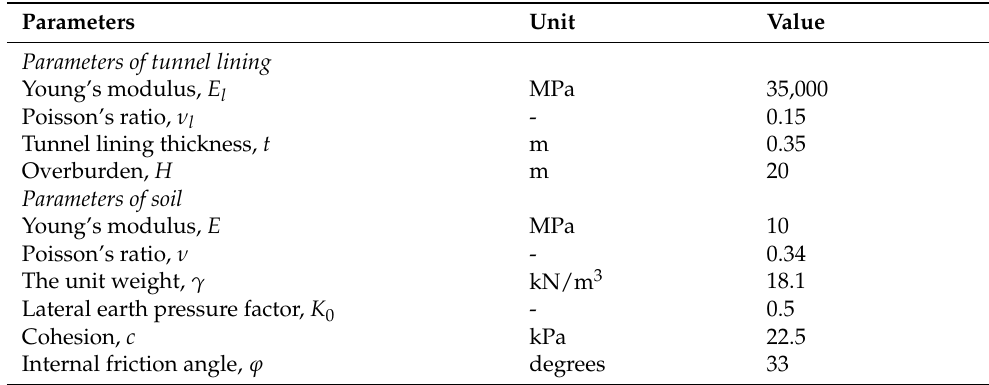
Table 1. Parameters of the soil and tunnel lining.